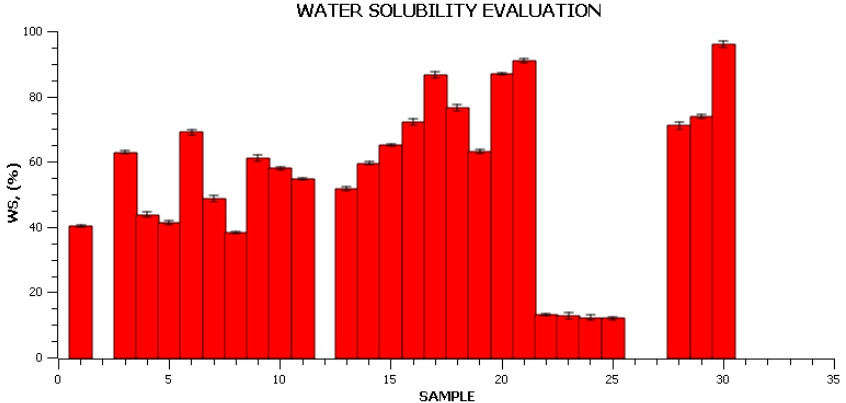
Figure 1. Water solubility of the films with addition of stevia powder.